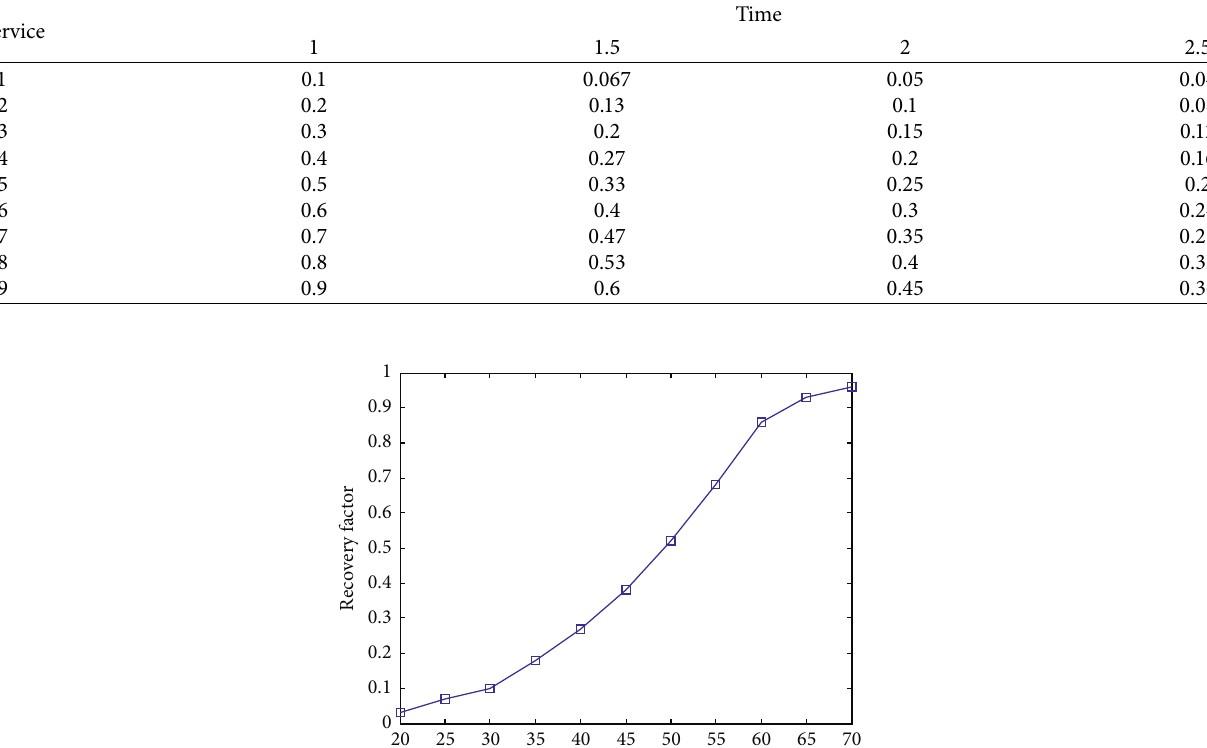
Table 2: Online processing efficiency analysis table.